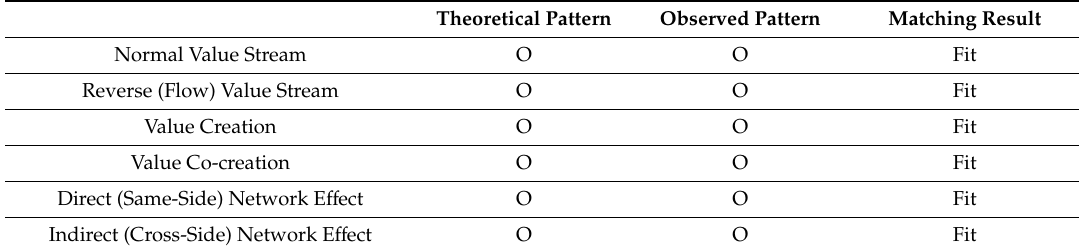
Table 4. Third type of platform business model pattern